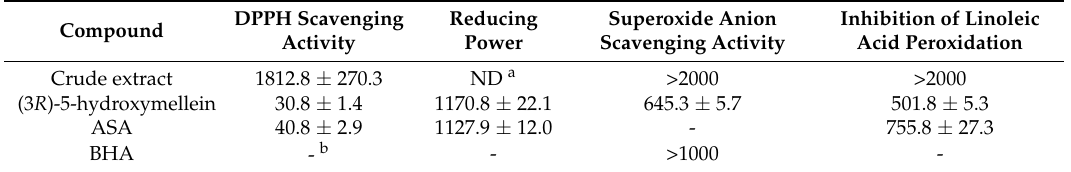
Table 1. Antioxidant activities (IC 50 ; µ g/mL) of ELF000039 crude extract, purified F2 ((3 R )-5- hydroxymellein), and positive controls (ASA and BHA).